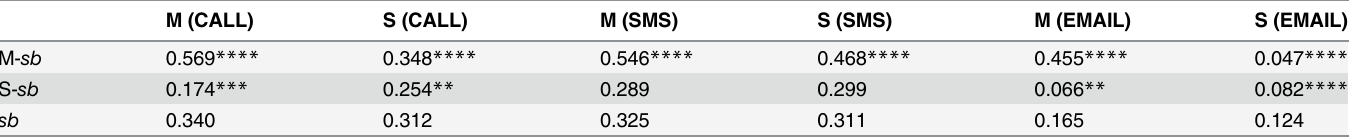
Table 2. Social Balance vs. Social Status. The social balance ratio of staffs with different status in companies in three communication networks. M: Manag- ers; S: Subordinates. M- sb : social balance ratio of manager-friends; S- sb : social balance ratio of subordinate-friends; sb : social balance ratio of all friends. M